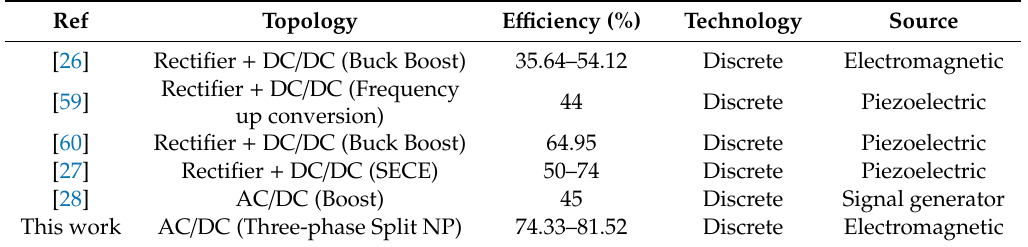
Table 25. Comparison of di ff erent converters for Alternate Current / Direct Current (AC / DC) conversion. Ref